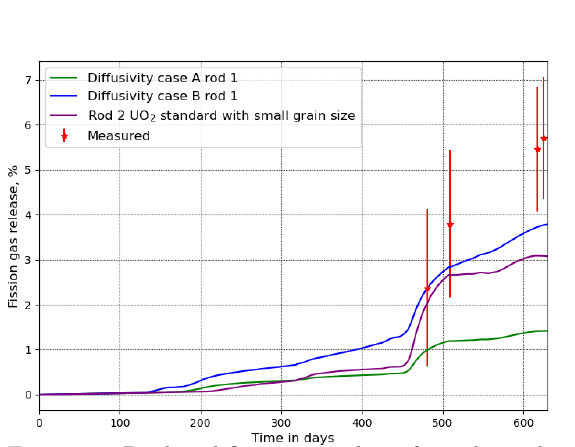
Figure 6. Predicted fission gas release for rod 1 and